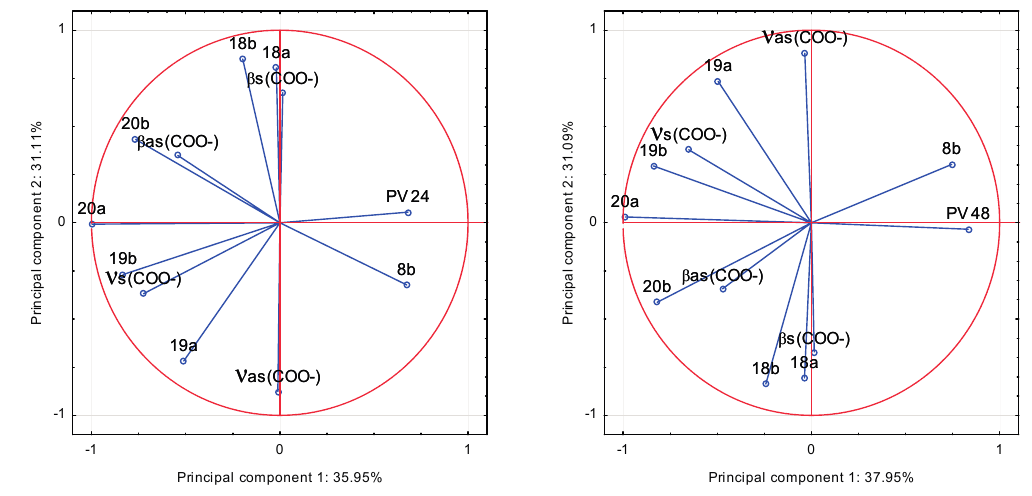
Figure 10. The values of the band wavenumbers in the FT–IR spectra of trans o -coumaric acid and alkali metal o -coumarates in relation to the degree of growth inhibition of the bacteria Proteus vulgaris (PV) after 24 and 48 h of incubation in the two principal components system.